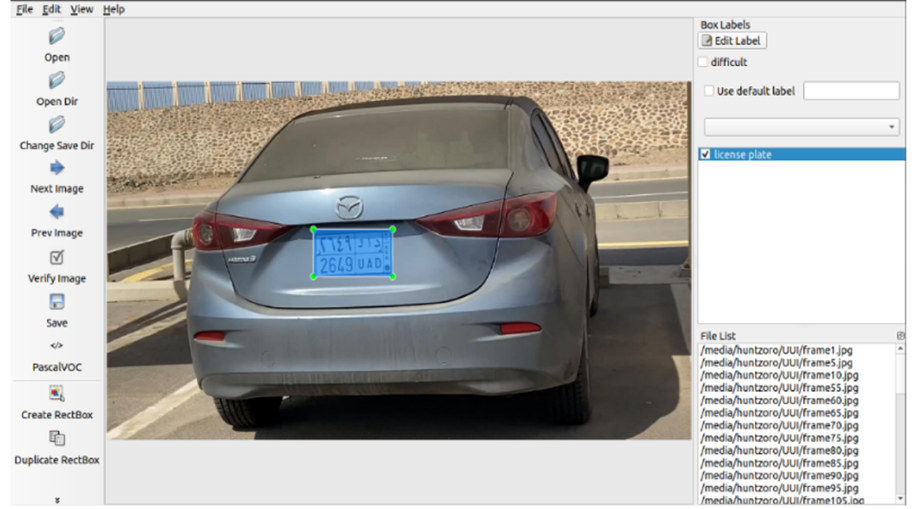
Figure 3. Annotation of the dataset using LabelImg [35].